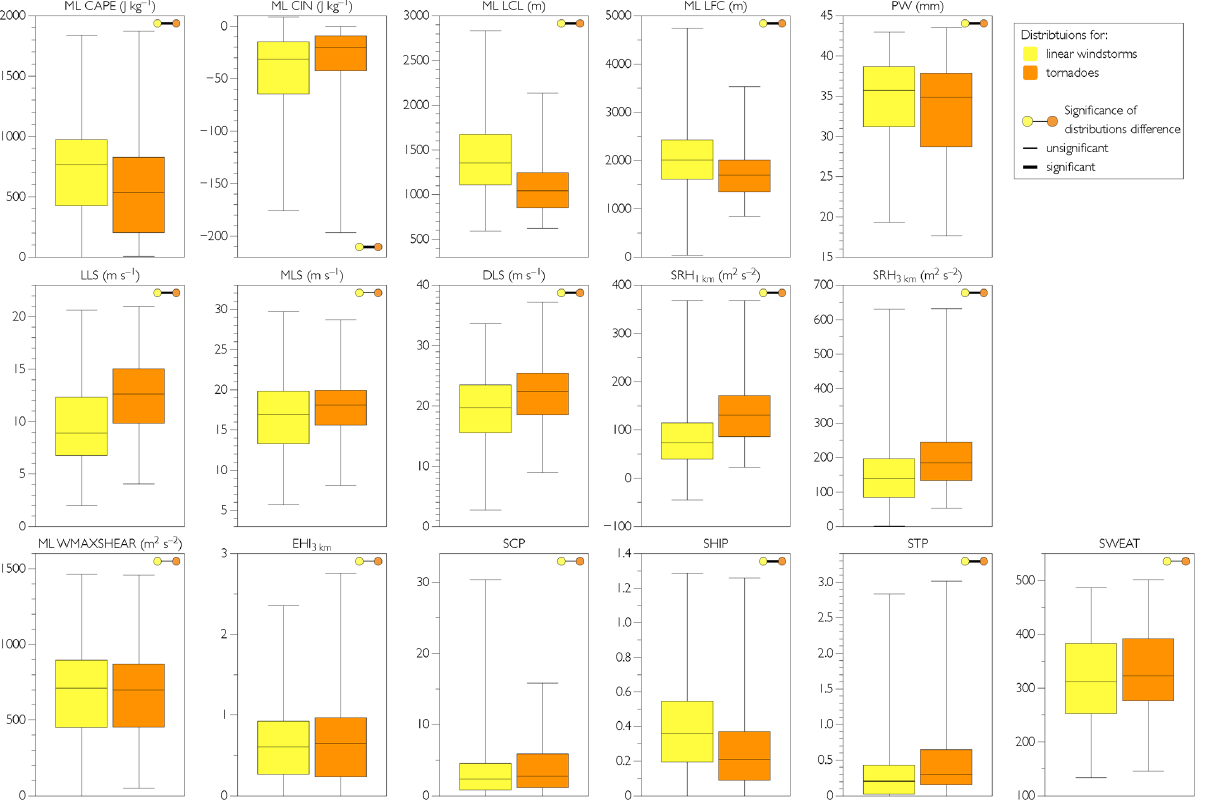
Figure 7. Distribution of various environmental variables separately for tornadoes (138 events) and linear windstorms (141 events). The statistically significant difference between distributions associated with tornadoes or linear windstorms is highlighted.